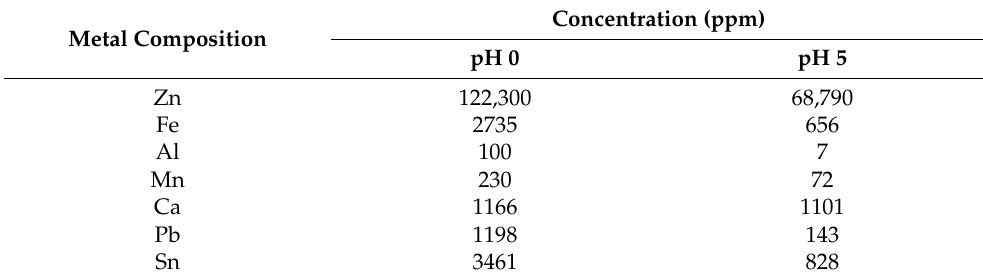
Table 1. Metal composition in the leaching solution of EAFD with nitric acid 3 M using ICP analysis. Metal